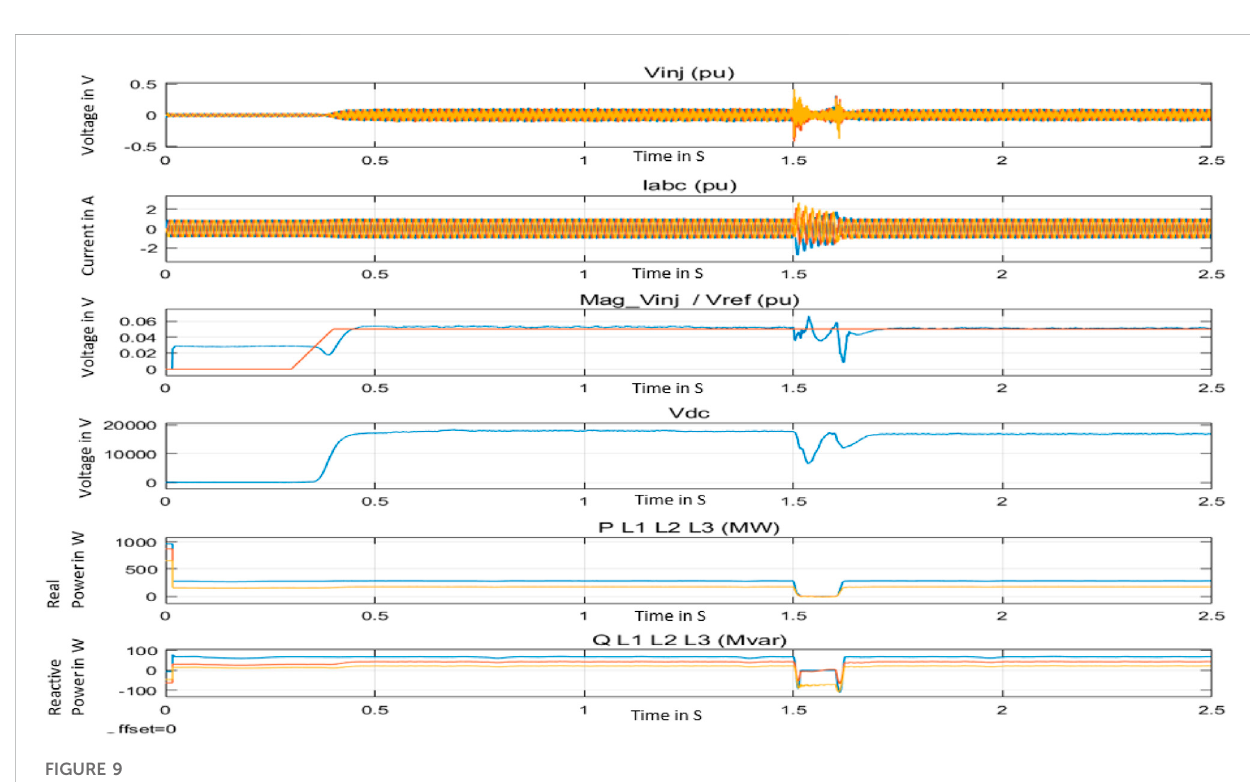
FIGURE 9 GWO-PI controller results after connecting the